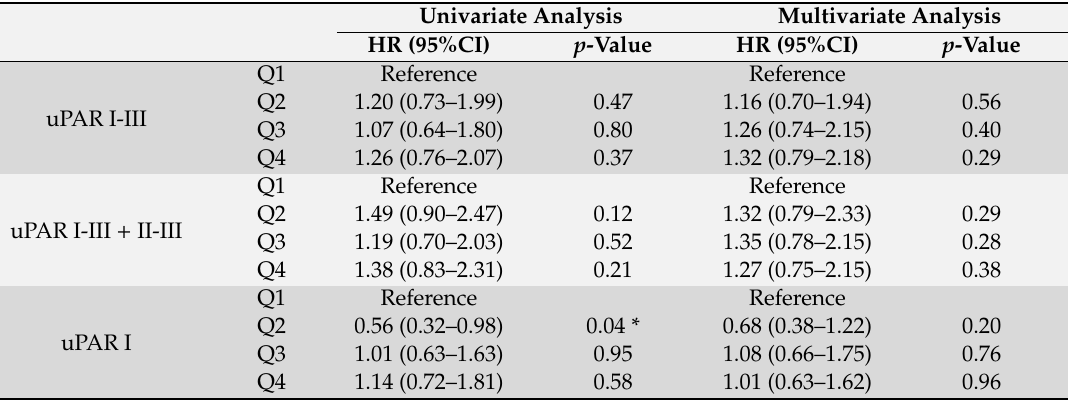
Table 2. Uni- and multivariate analysis of biochemical recurrence after radical prostatectomy (N = 532) stratified for plasma urokinase plasminogen activator receptor (uPAR) quartiles. Multivariate analysis was adjusted for age at start of treatment, prostate-specific antigen, pathological Gleason score, margin status, pathological tumor stage and lymph node status. Abbreviations: HR: Hazard ratio; 95%CI: 95% confidence interval; Q: Quartile. * Statistically significant as defined by p -Value below